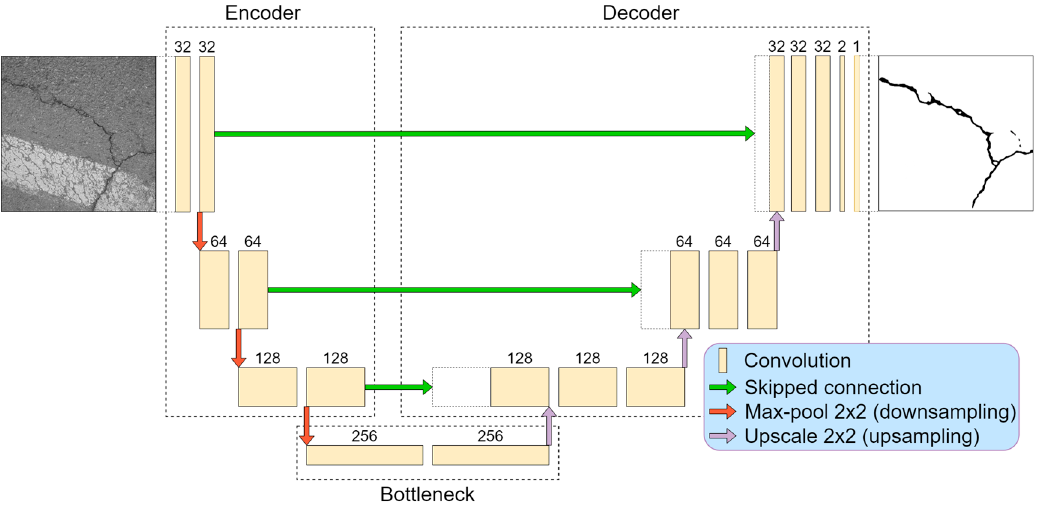
Figure 1. U-Net convolutional neural network structure.